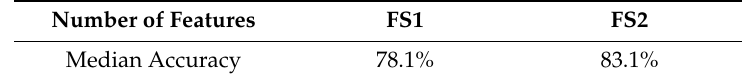
Table 5. Median classification accuracy according to the number of features: common statistical features (n = 42) and the common features with the extra 16 features (n = 58)